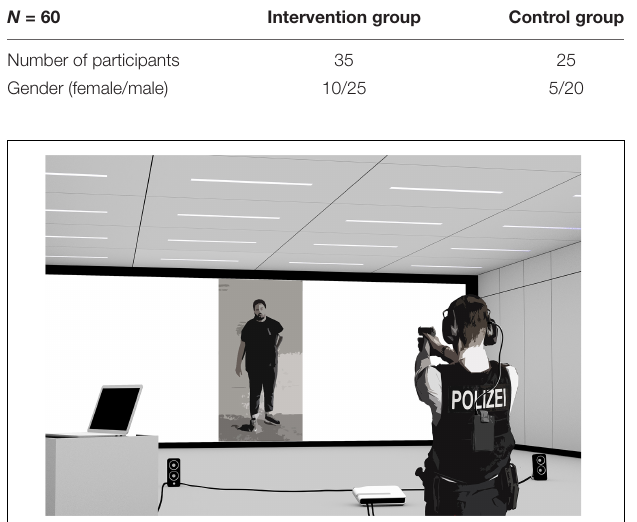
TABLE 1 | Group characteristics.